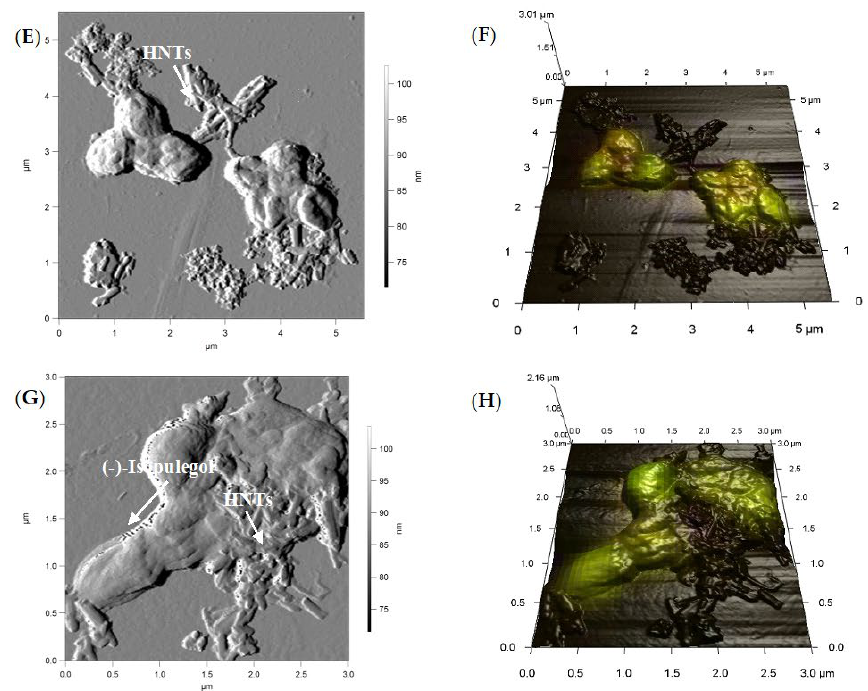
Figure 5. AFM and combined AFM-CLSM images of R . rhodochrous IEGM 1362 (biotic control A , B ) in the presence of (–)-isopulegol ( C , D ), HNTs ( E , F ), and (–)-isopulegol and HNTs ( G , H ). Green fluorescence indicates living cells, red fluorescence indicates dead cells.